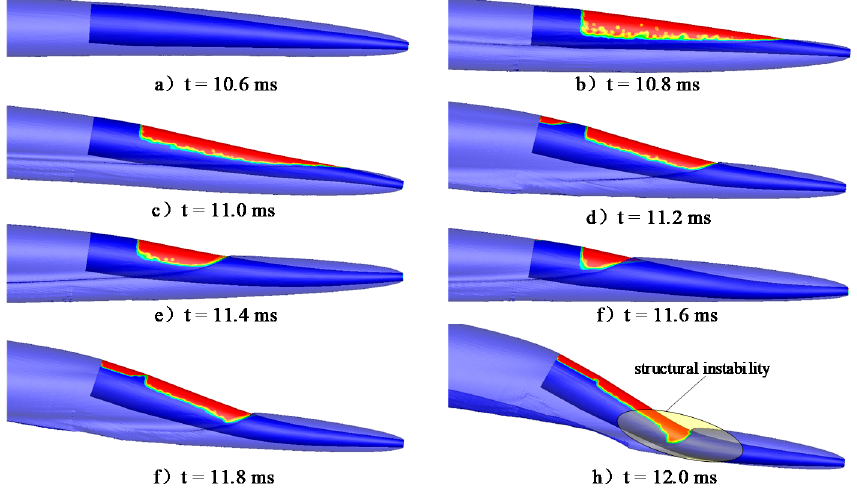
Figure 10. Deformation of supercavitating projectile and wetted status in vibration divergence stage.